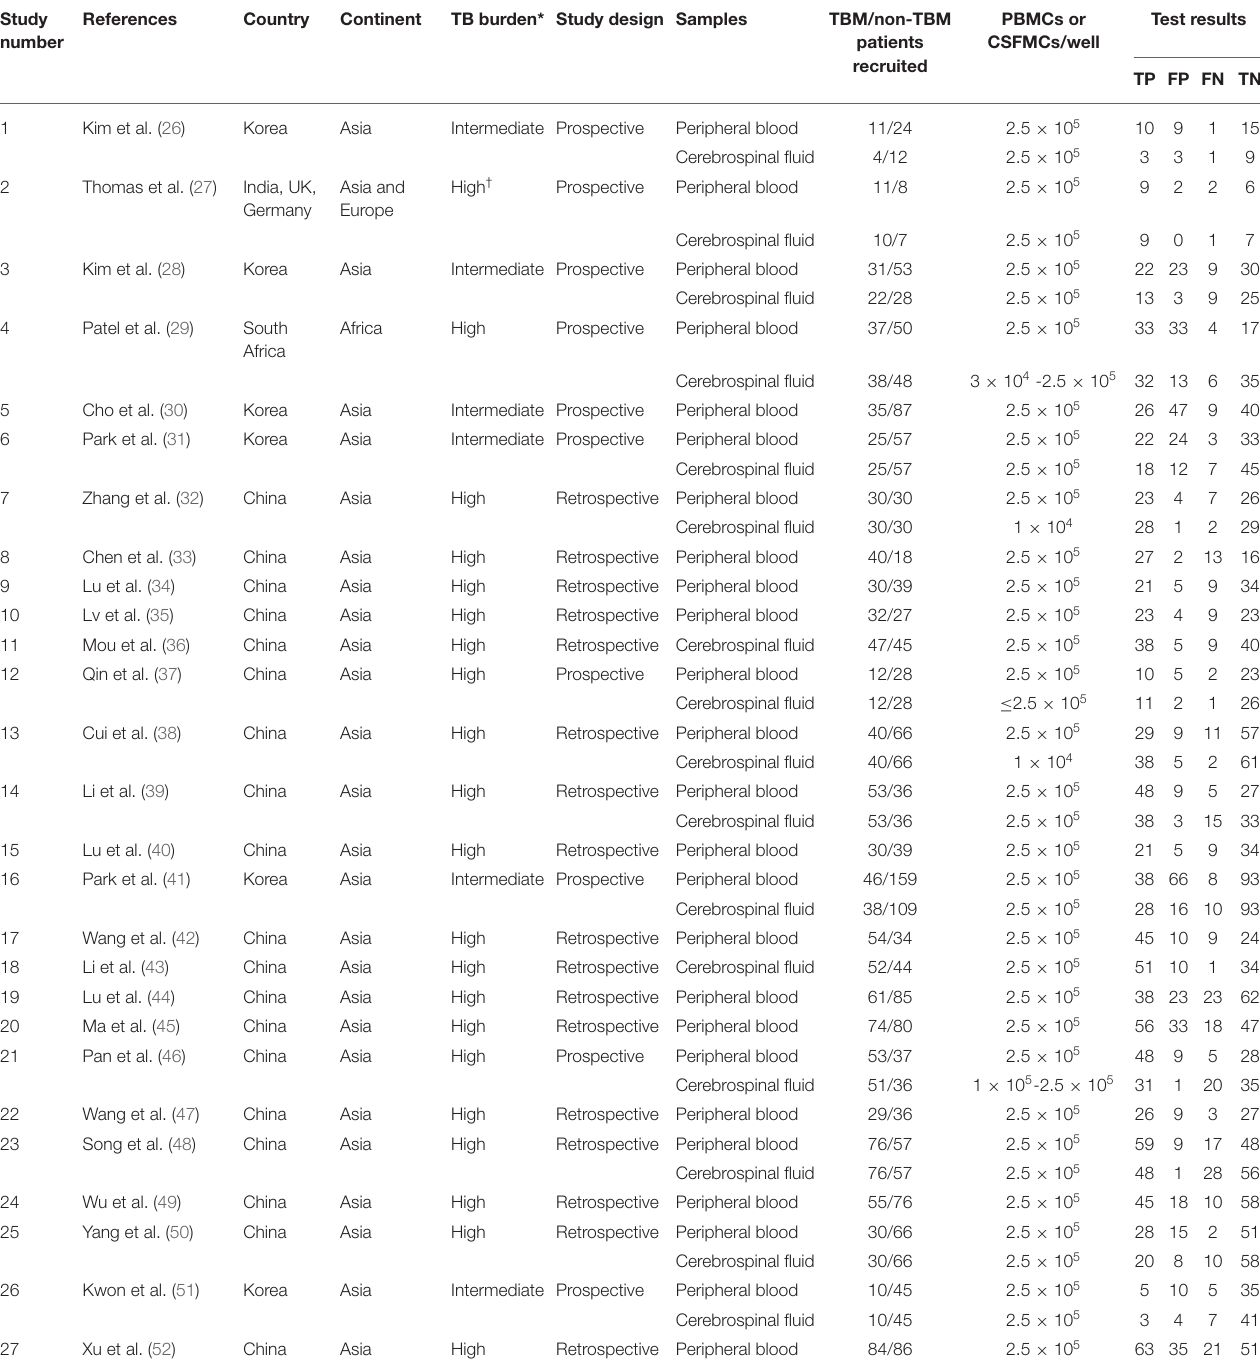
TABLE 1 | Summary characteristics of studies included in